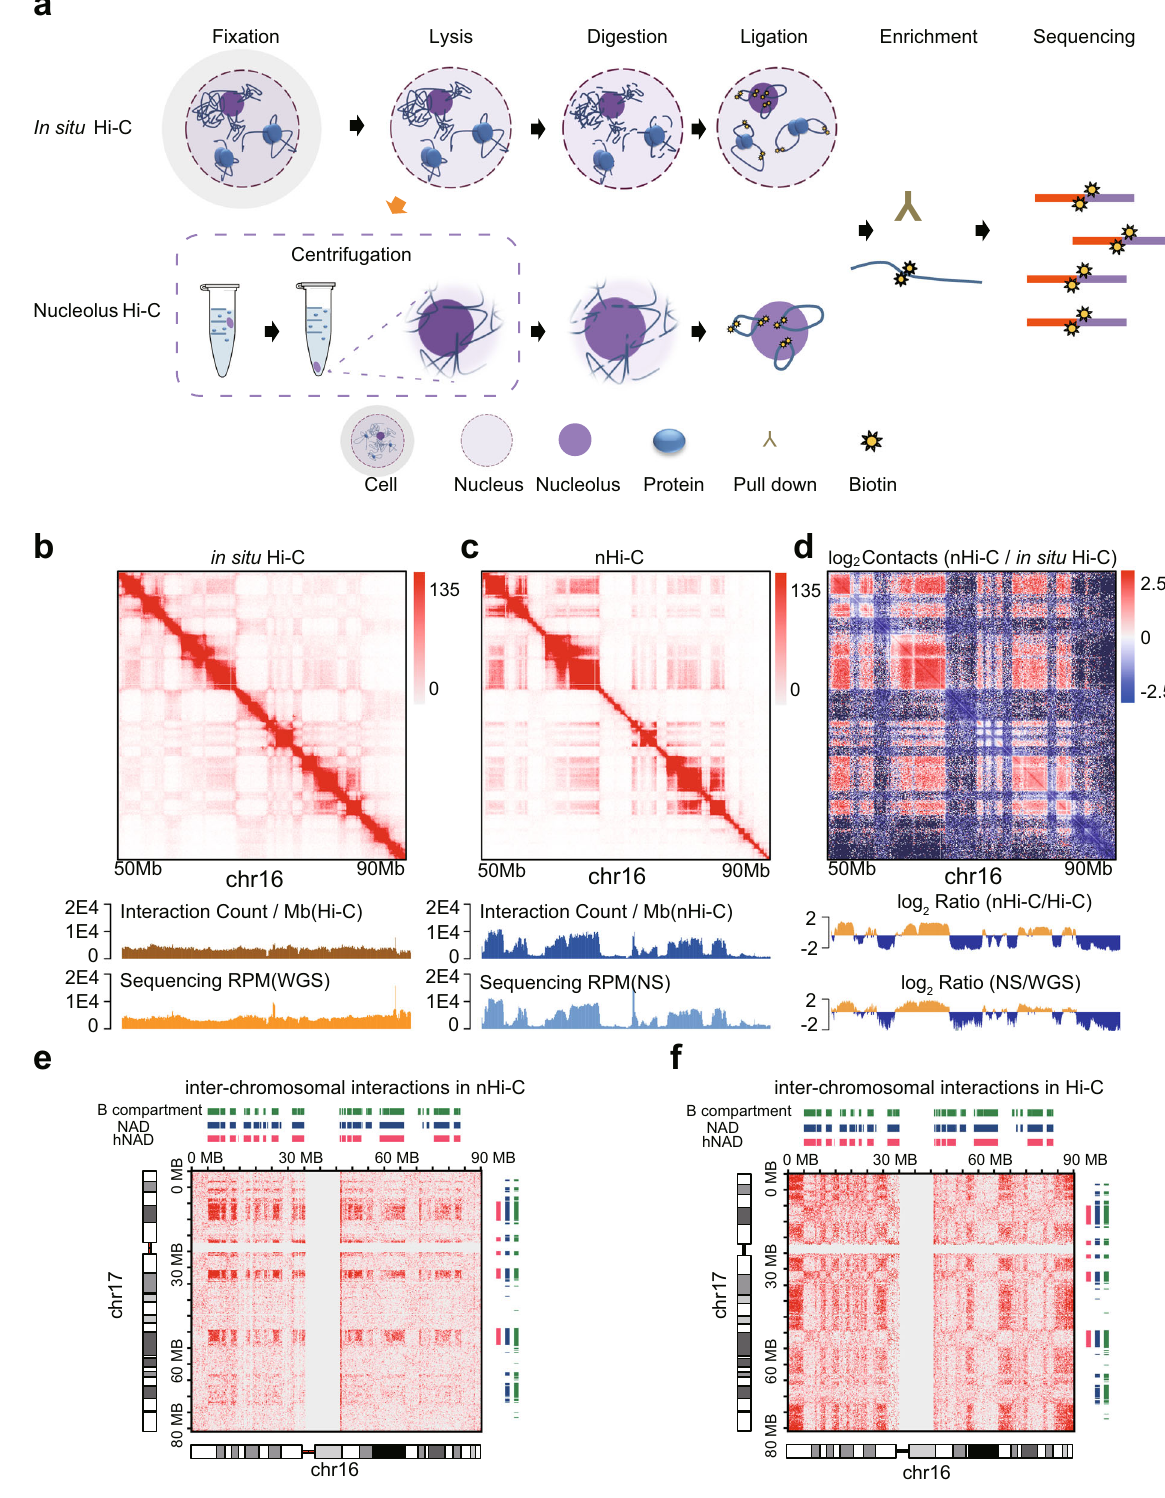
Fig. 1 | nHi-C preferentially captures nucleolus-associated chromatin interac- tions.a FlowchartofnHi-C.ForcomparisonwithinsituHi-C,nHi-Cwasperformed with isolated nucleoli. b , c Interaction heatmaps of in situ Hi-C and nHi-C. WGS: whole-genome sequencing, RPM: reads per million for each chromosome bin, NS: nucleolus sequencing. d Interaction heatmap showing the log2 fold-change in